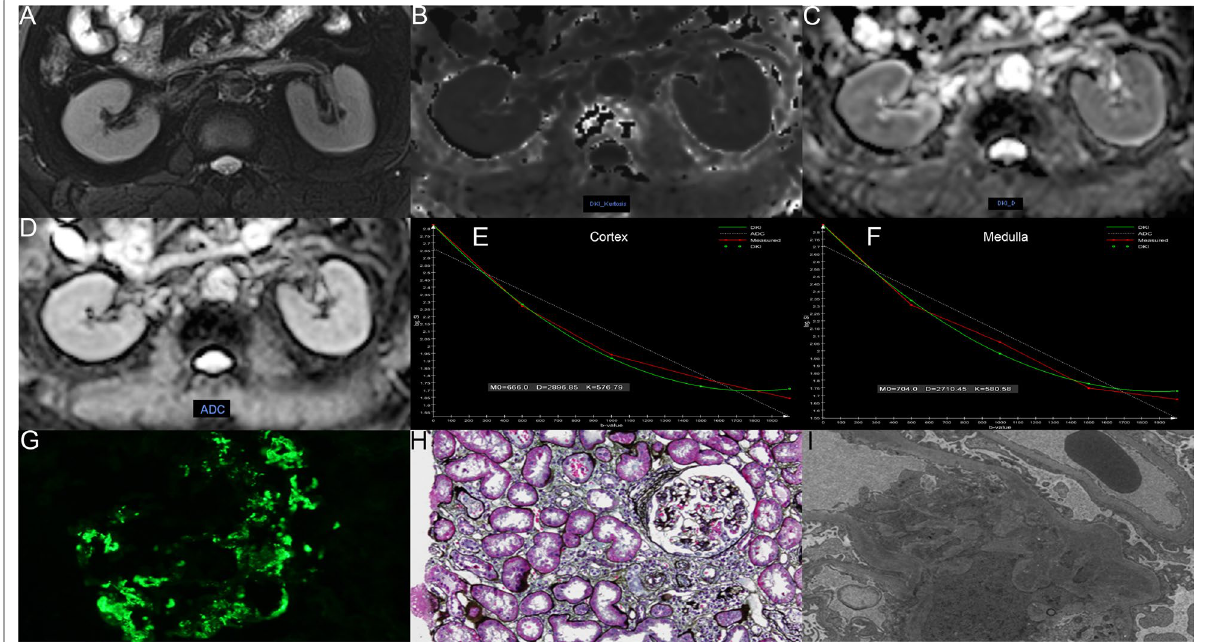
77.4 mL/min/1.7 3m 2 . A – I axial T2-weighted image, MK, MD, ADC, =